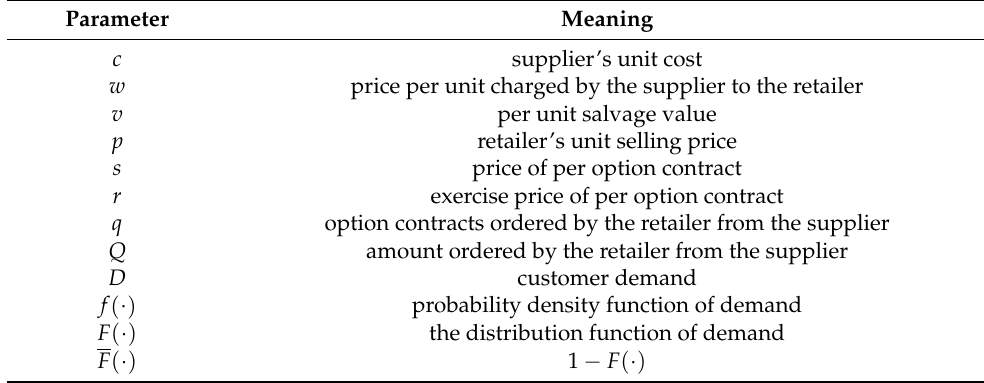
Table 1. Parameters and meanings. Parameter